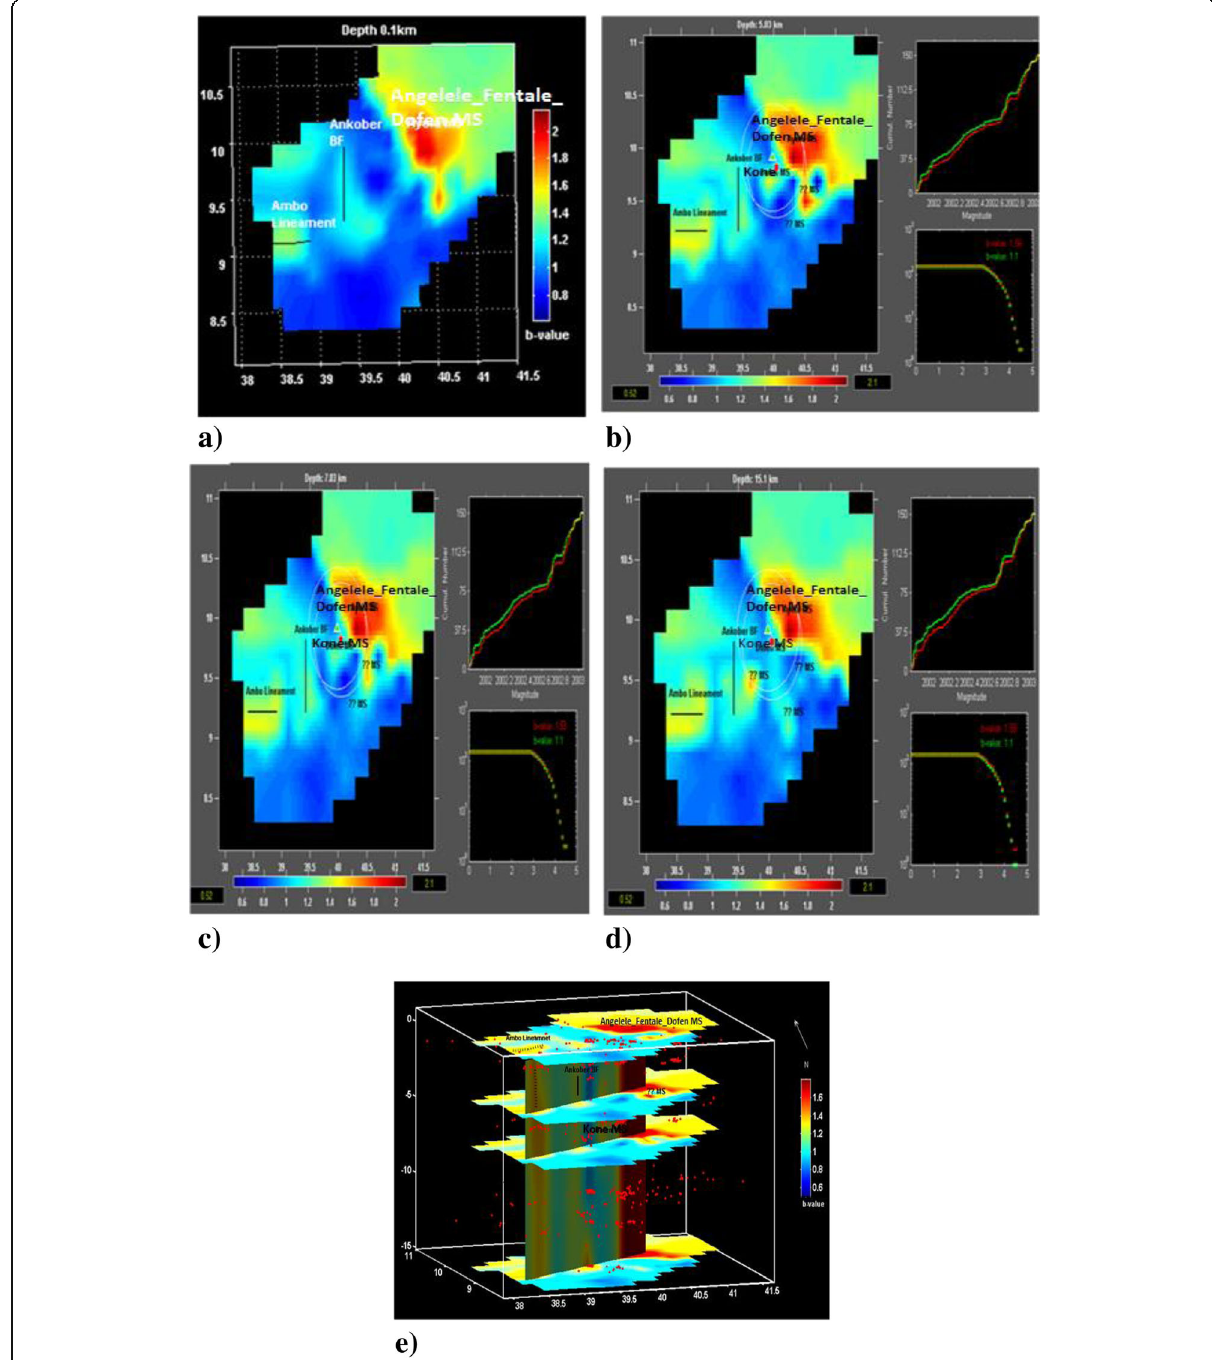
Fig. 11 Depth Slices of b-values for NMER at depth: ( a ) 0.1 km, ( b ) 5 km ( c )7 km ( d ) 15 km ( e ) 3D map of b-value with red dot posted over it showing earthquake events in Moment magnitude Mw ≥ 3.0 within the specified period of completeness Fig. 10(b). The black horizontal and vertical lines are indicated respectively by Ambo lineament and Ankober boarder